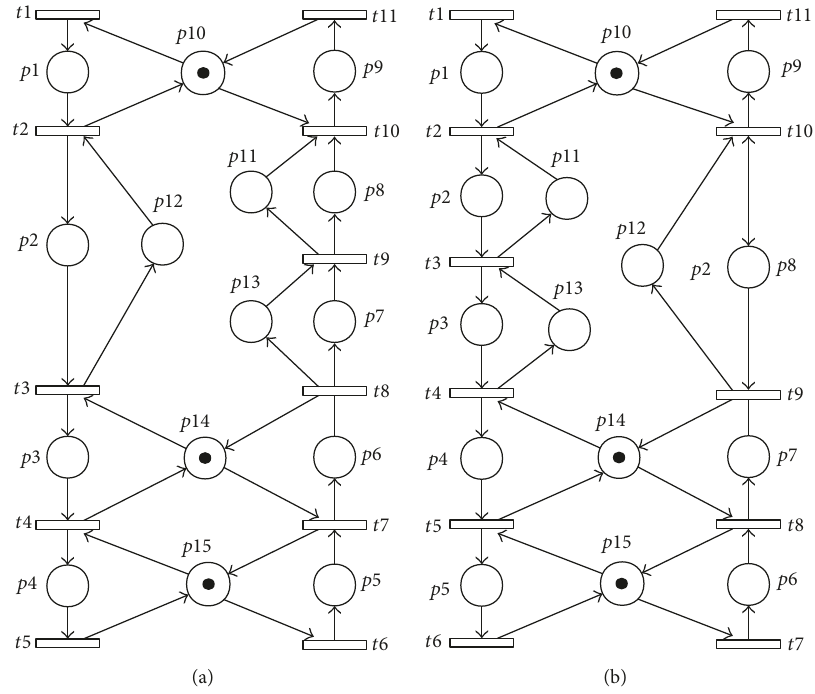
Figure 11: Two reduced S 3 PR models derived from Figure 10.